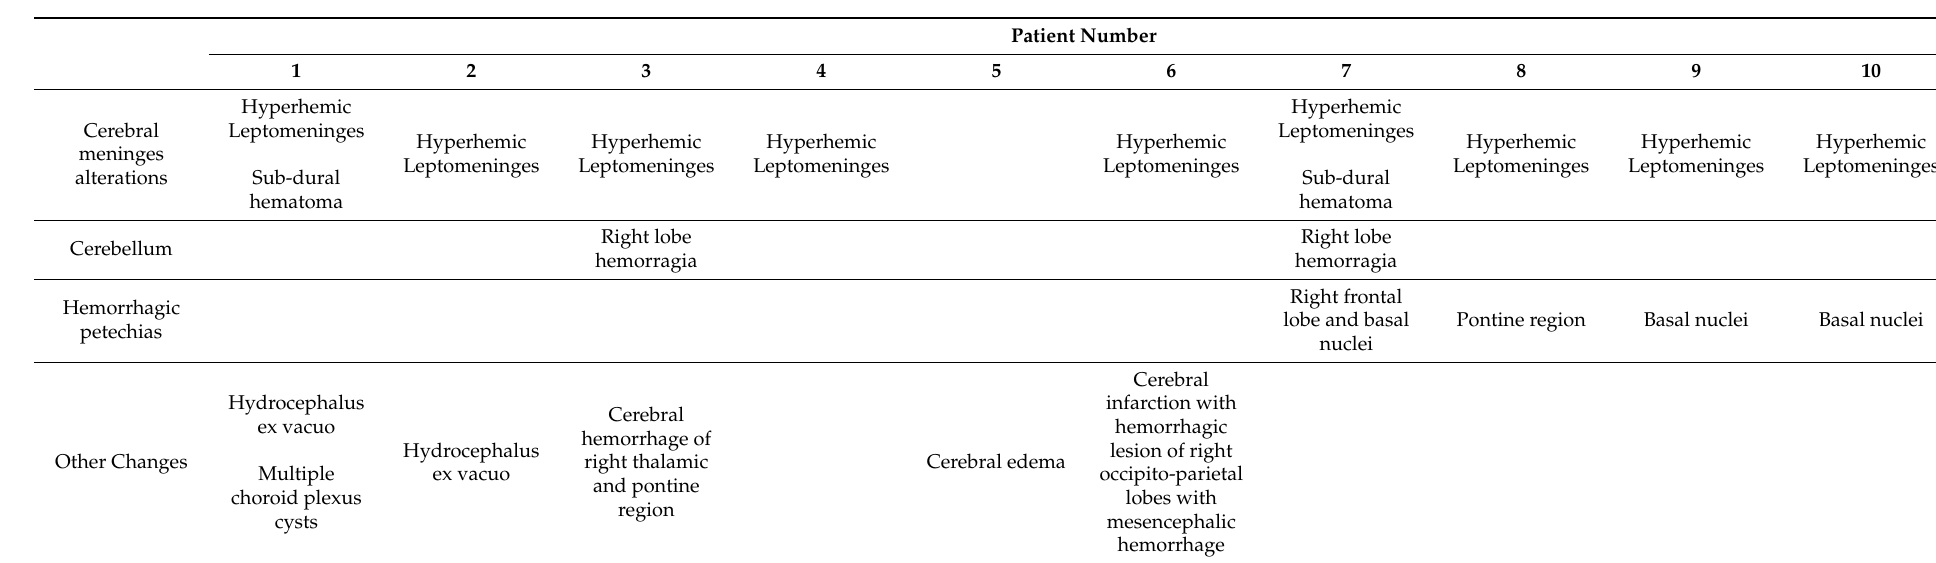
Table 2. Brain gross